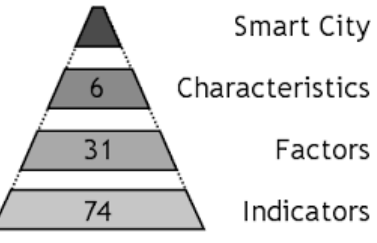
Figure 1. Description of smart cities. Source: Griffinger, R. [93].